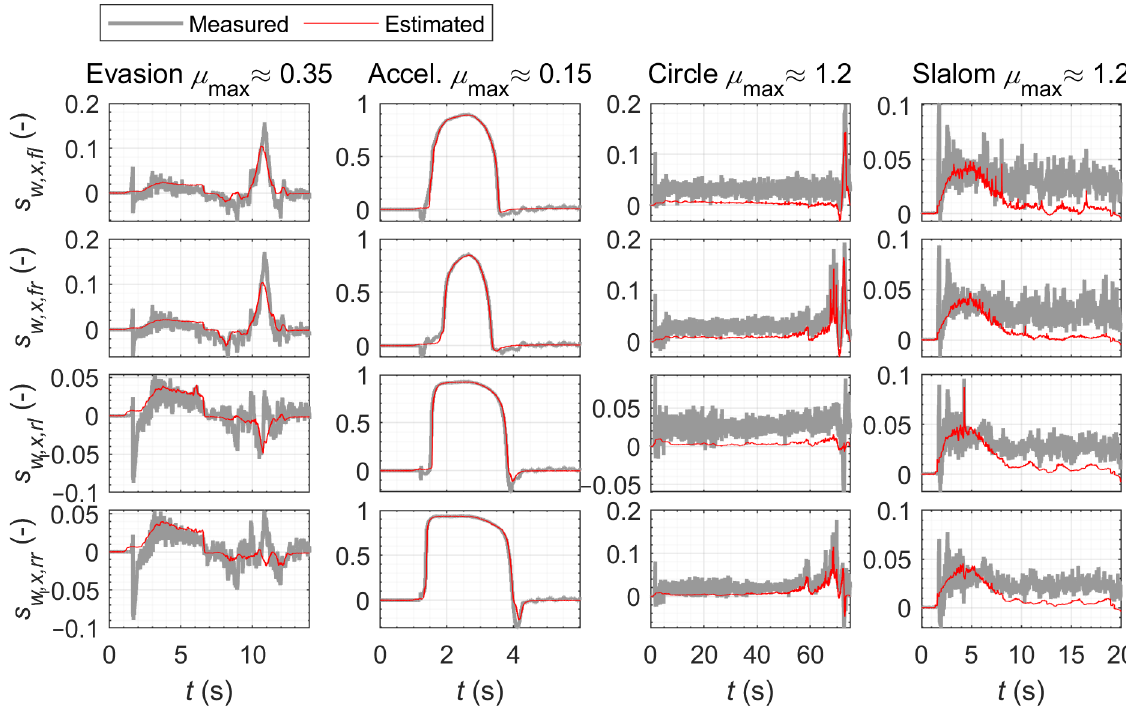
Figure A5. Test data: measured and estimated longitudinal tire